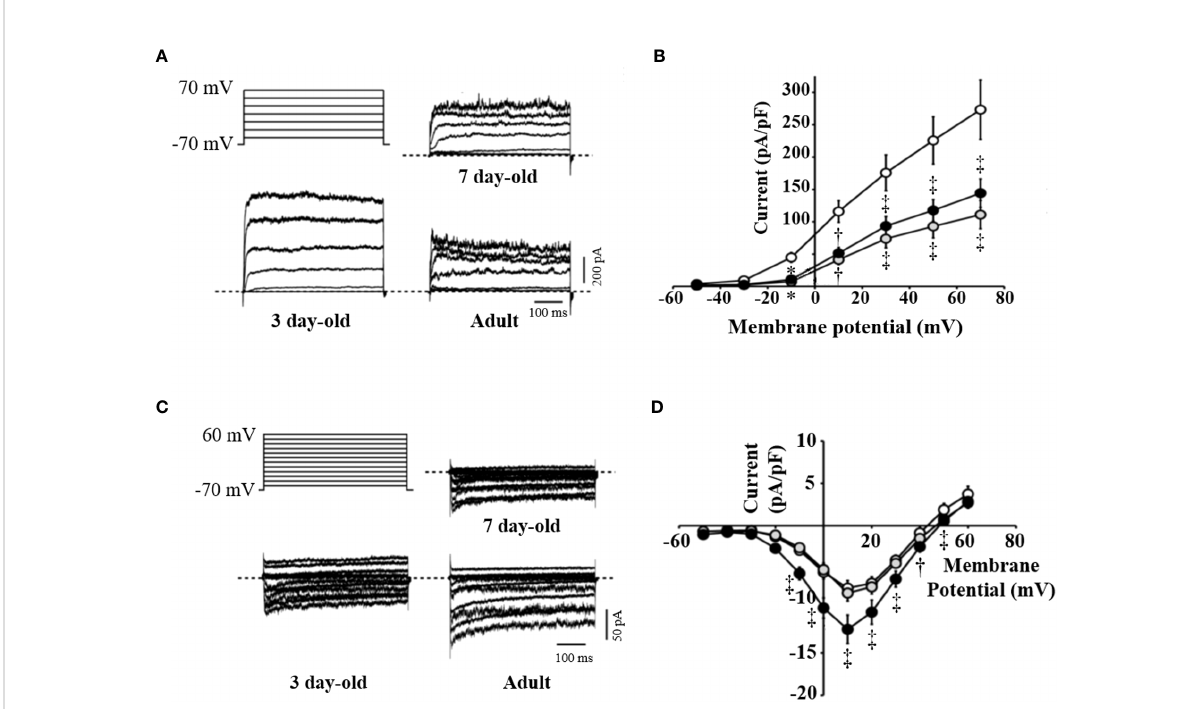
FIGURE 4 Activity of voltage-dependent K + and Ca 2+ channels in beta cells of 3-, 7-day-old neonatal and adult pig islets. Voltage-dependent K + (Kv) channels or voltage-dependent Ca 2+ channels (VDCCs) were recorded in response to a series of membrane depolarizations from a holding potential of -70 mV. (A) Stimulation protocol and representative traces of Kv currents from islet beta cells of 3- (n=17), 7-day-old neonatal (n=17) and adult pigs (n=10). (B) Averaged current-voltage relationship of Kv channel activity in these groups. (C) Stimulation protocol and representative traces of VDCC currents from islet beta cells of 3-day-old (n=21), 7-day-old neonatal (n=22) and adult pigs (n=19). (D) Mean current-voltage relationship of VDCC activity in these groups. *p <0.001, † p <0.01, ‡ p <0.05 compared with islets from 3-day-old pigs. White, gray, and black circles represent data from 3-day-old, 7-day-old, and adult pig islets,